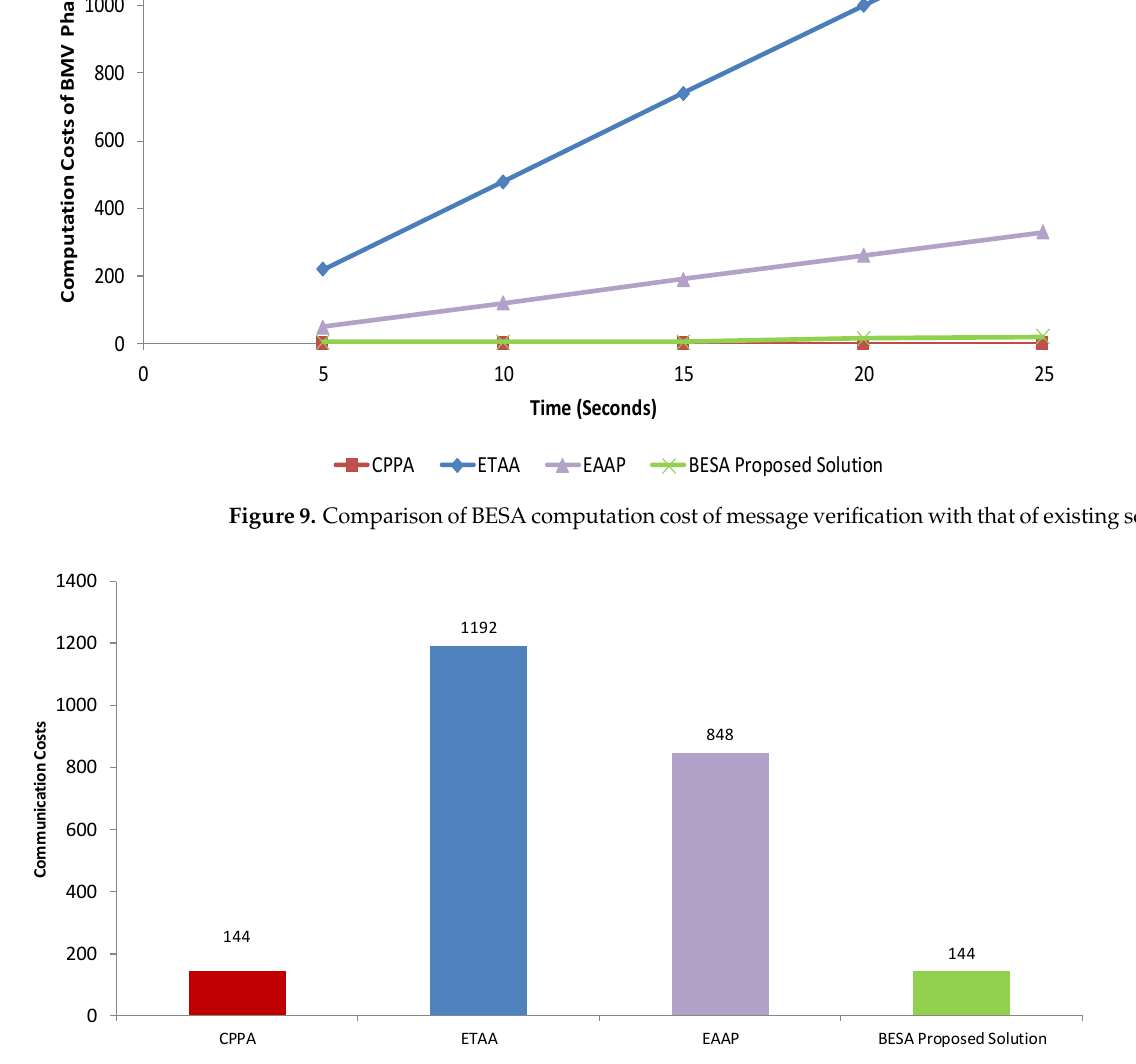
Figure 10. Comparison of BESA communication cost with that of existing schemes.